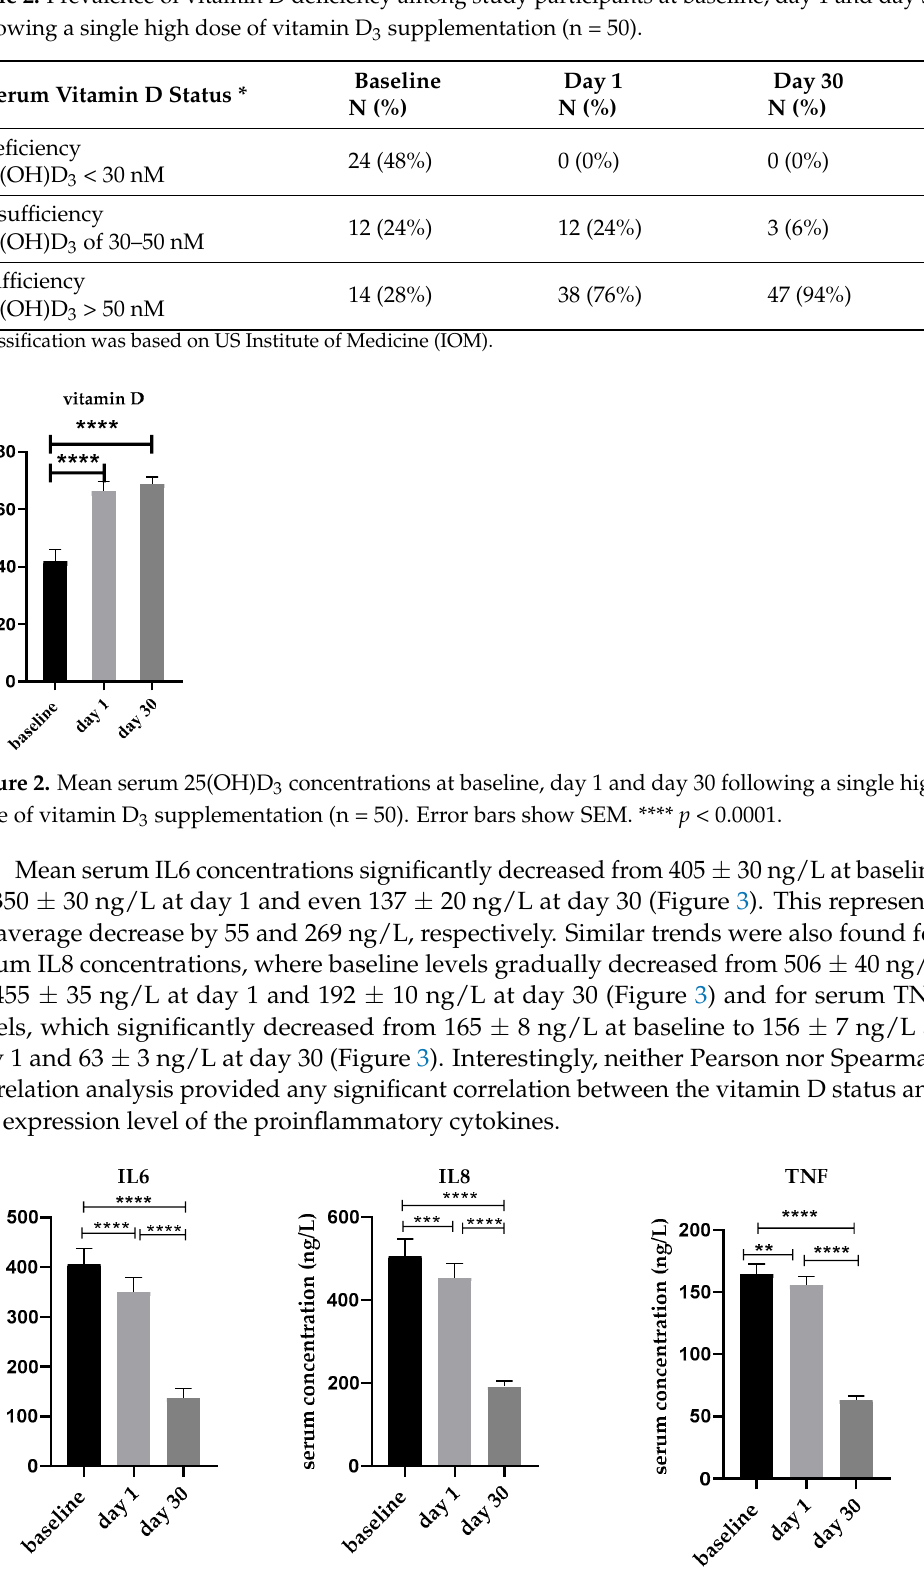
Figure 3. Mean serum levels of the proinflammatory cytokines IL6, IL8 and TNF at baseline, day 1 and day 30 following a single high dose of vitamin D 3 supplementation (n = 50). Error bars show SEM. ** p < 0.01, *** p < 0.001, **** p < 0.0001.